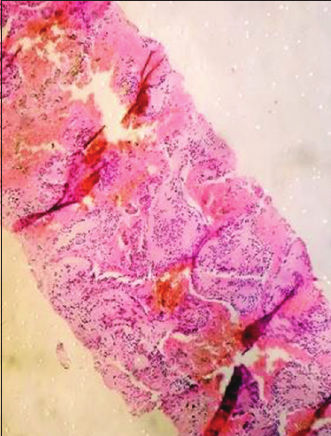
Fig ure 4: Tumor cells positive for synaptophysin